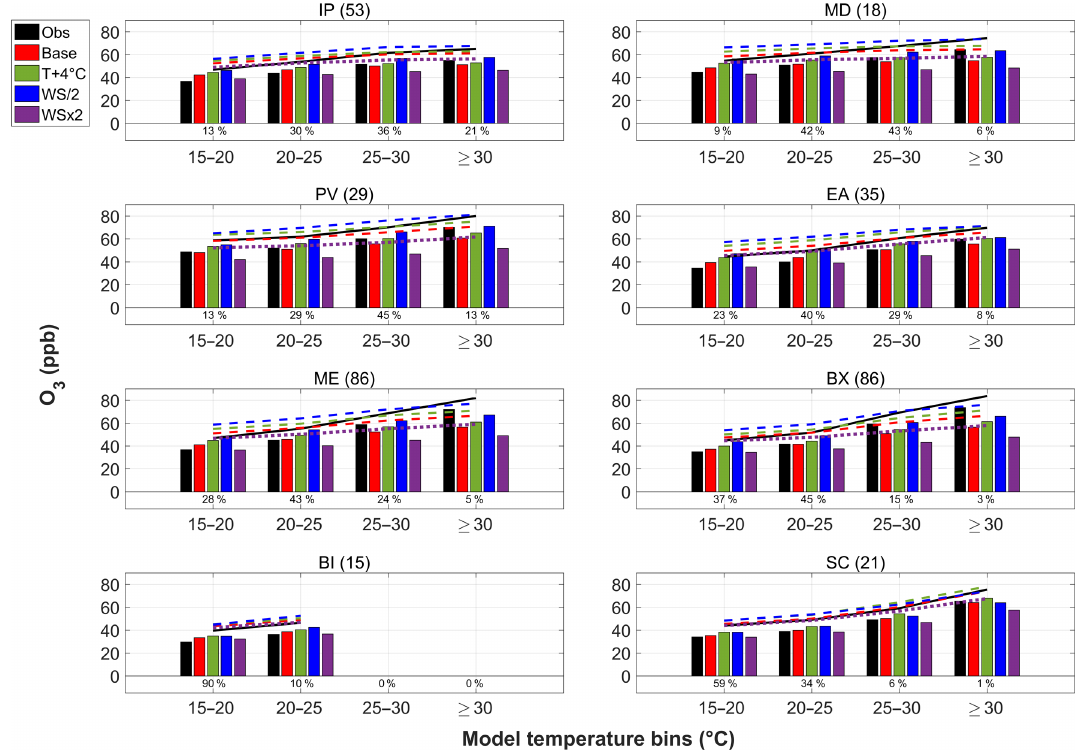
Figure 12. Afternoon (12:00–18:00UTC) surface O 3 mixing ratios for each modeled temperature bin for various meteorological scenarios in eight European regions in summer 2010. Colored lines show the trends of the respective bars and are shifted up by 10ppb for visualization purposes. Percentage values below the bars indicate the fraction of the values assigned to each bin for each region. The number of stations available for each region is reported in parentheses at the top of each panel. A definition of the regions is given in Fig.